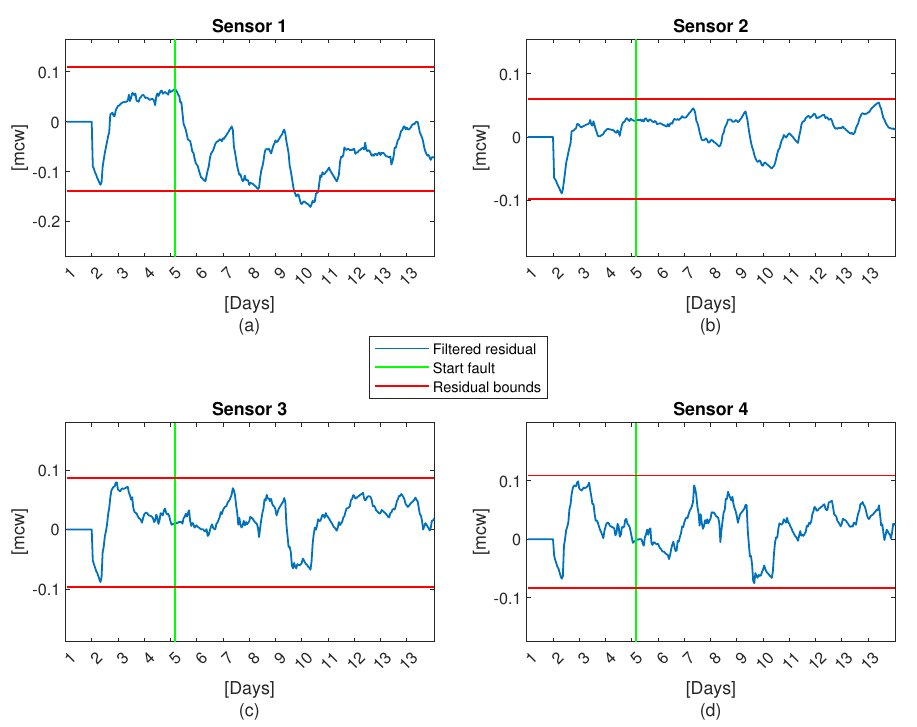
Figure 6. Graph of the filtered residual with a fault in sensor number 1 ( a ) 1st sensor, ( b ) 2nd senor, ( c ) 3rd sensor, and ( d ) 4th sensor.